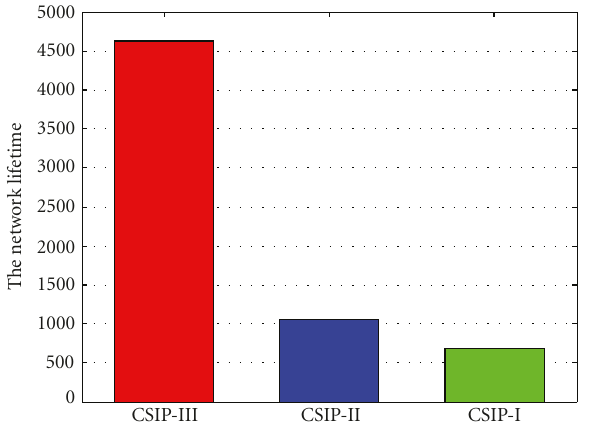
Figure 11: The network lifetime of di ff erent collaborative process- ing